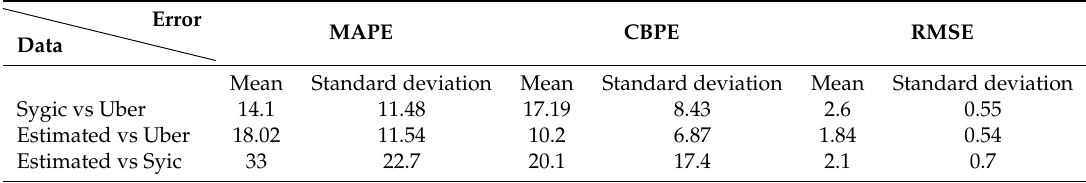
Table 5. Means and standard deviations of hourly errors of a